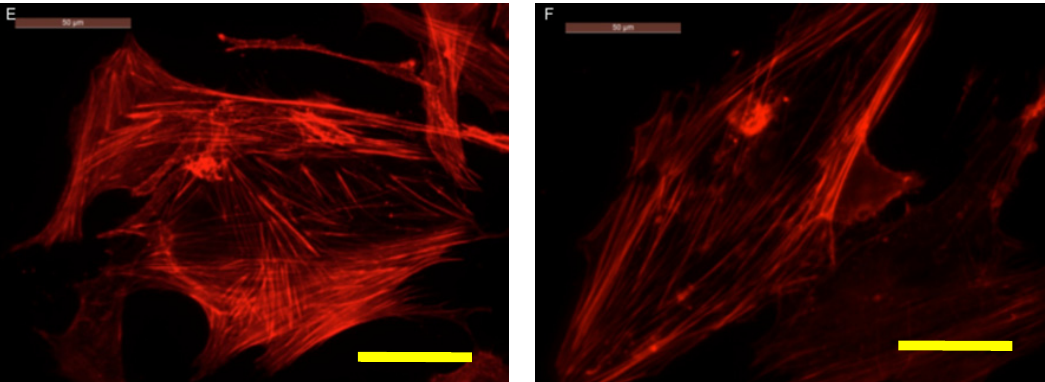
Figure 12. HOB ® osteoblasts grown on the glass are used as a reference control, shown in ( A , B ) after 48 h in culture, and examined with a confocal microscope. HOB ® osteoblasts grown on SCS8 sample after 48 h ( C , D ) and 72 h ( E , F ) and examined with a confocal microscope. In red, rhodamine-phalloidine immunolabeled actin cytoskeletal fibers showing polarization to material and actin stress fibers development. In all cases yellow bar 50 μ m.